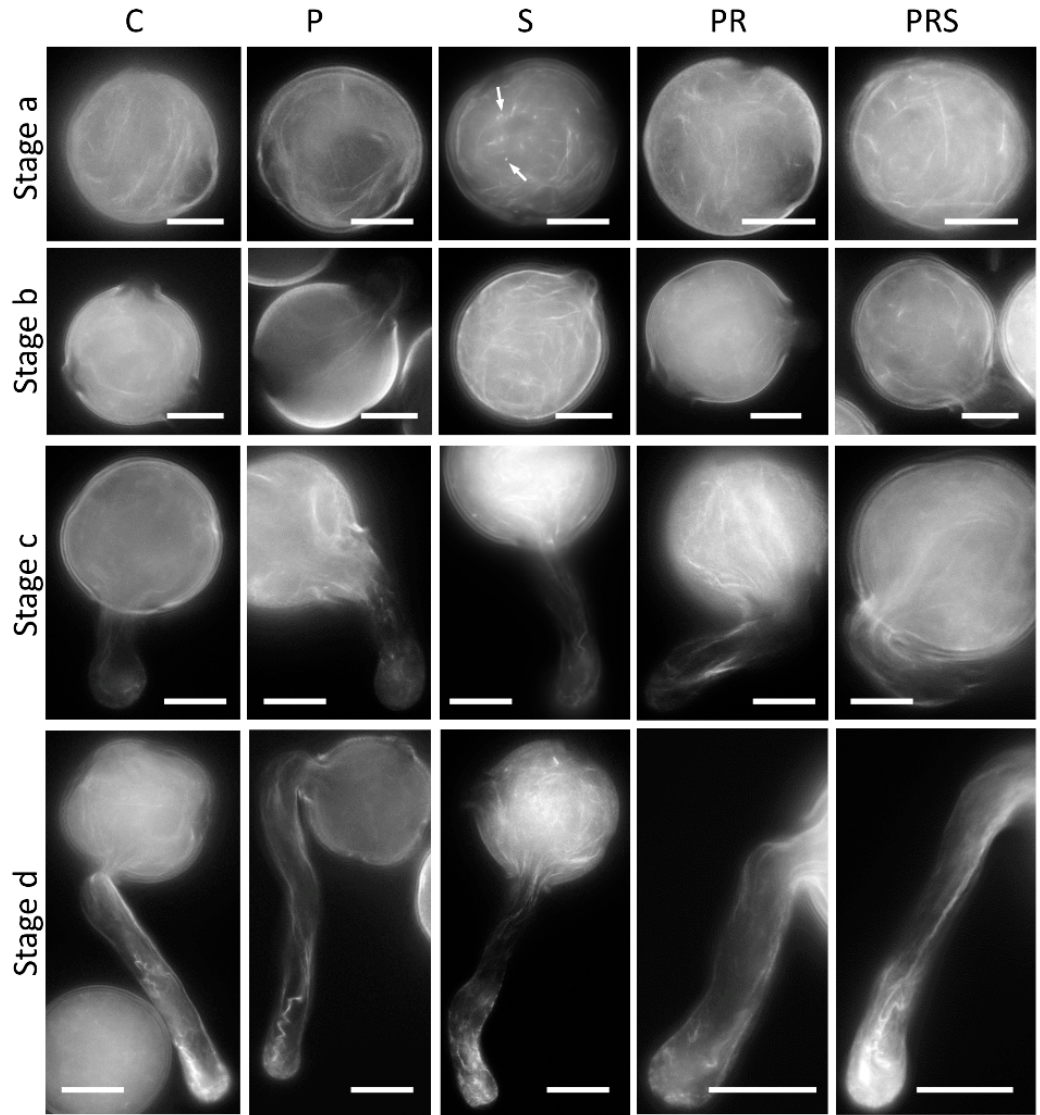
Figure 7. Distribution of actin filaments in control sample (C); primed sample (P); stressed sample (S); primed and recovered sample (PR); primed, recovered and stressed sample (PRS). Stage a: actin filaments in the ungerminated grain; Arrows indicate fragmented actin filaments. Stage b: emerging pollen tube stage; Stage c: pollen tubes with length comparable to the pollen grain diameter; Stage d: pollen tubes with increased length. Figure reports the most representative images. At least 30 pollen grains and tubes were analyzed. Refer to the main text for a more detailed description. Bars 20 µ m.